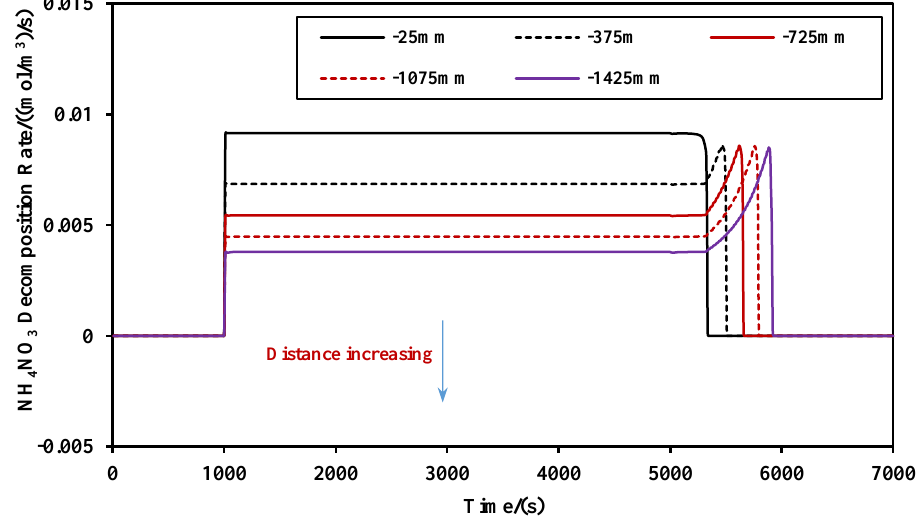
Figure 7. The relationship between the NH 4 NO 3 decomposition reaction rate and the change of time. ( T = 150 °C, NO 2 /NO x = 0.25).